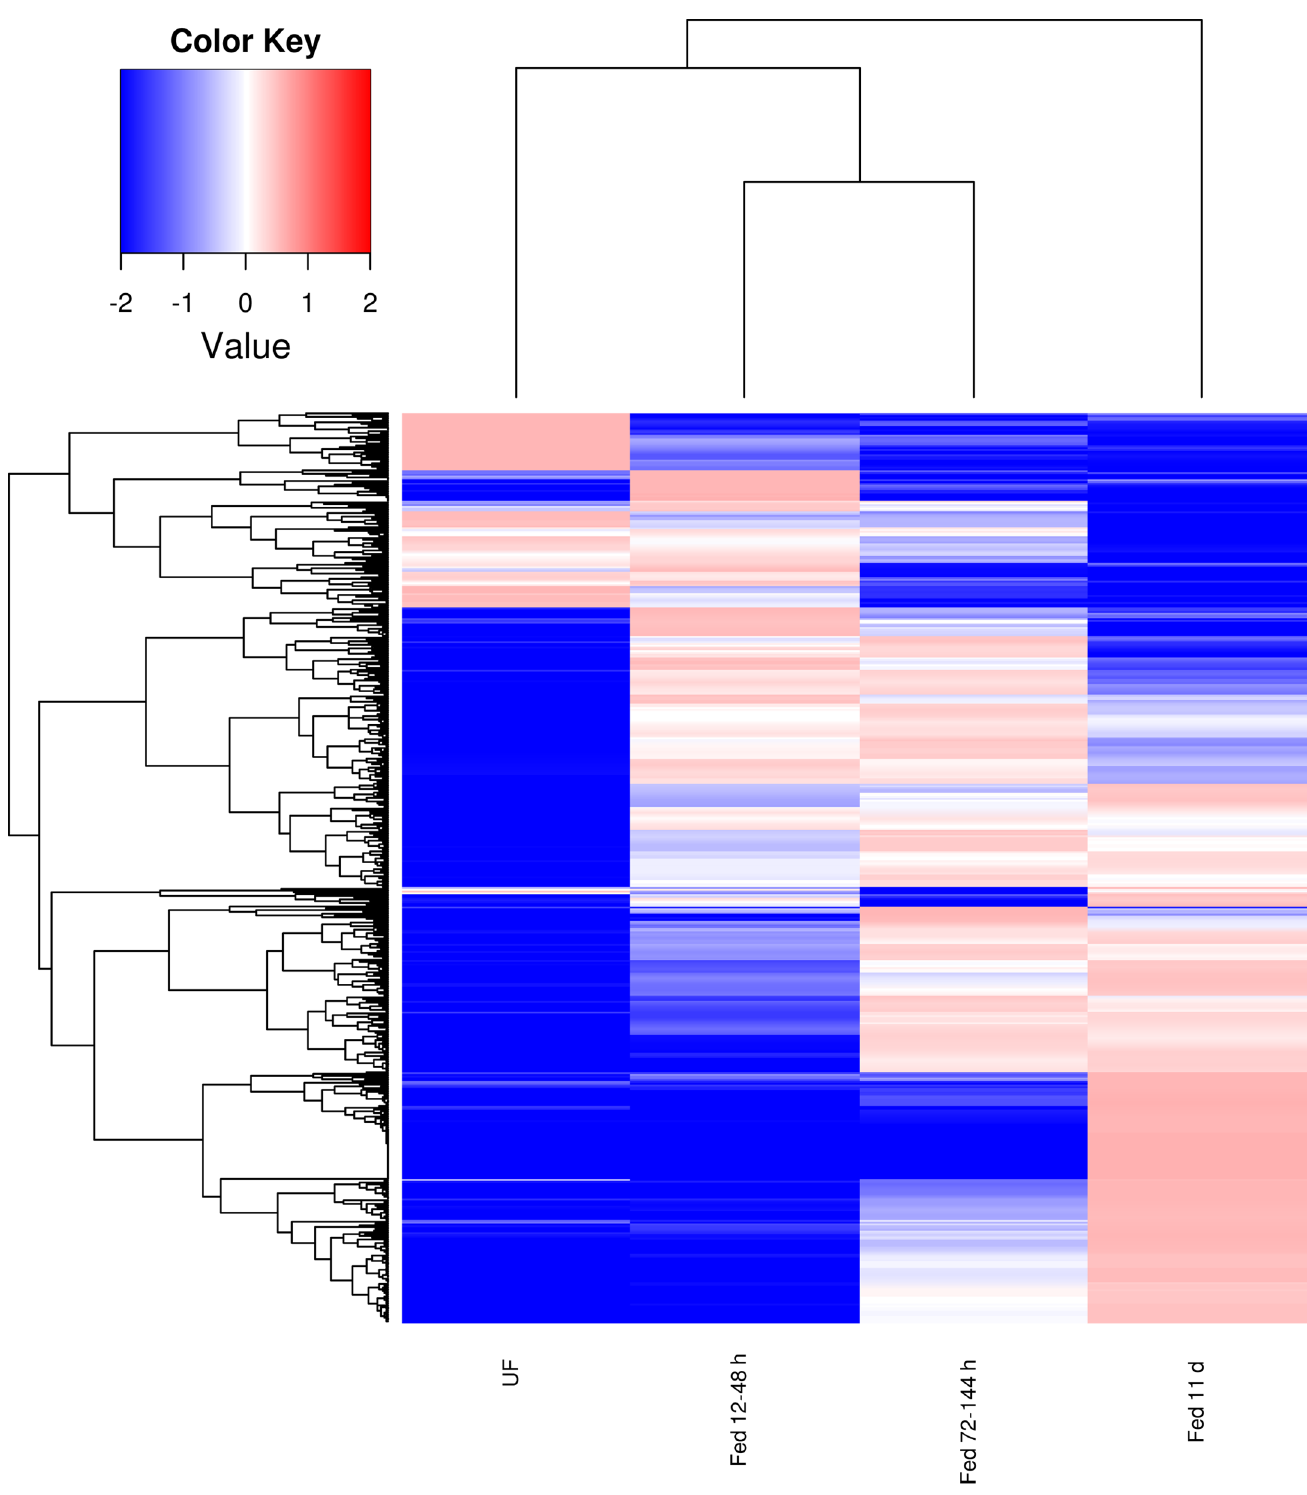
Fig 1. Heat map displaying 836 coding sequences (CDS) that are not uniformly expressed in the four libraries and showing a standard deviation of 1 or more regarding the log(10) transformation of the average normalized data. For more details, see text.